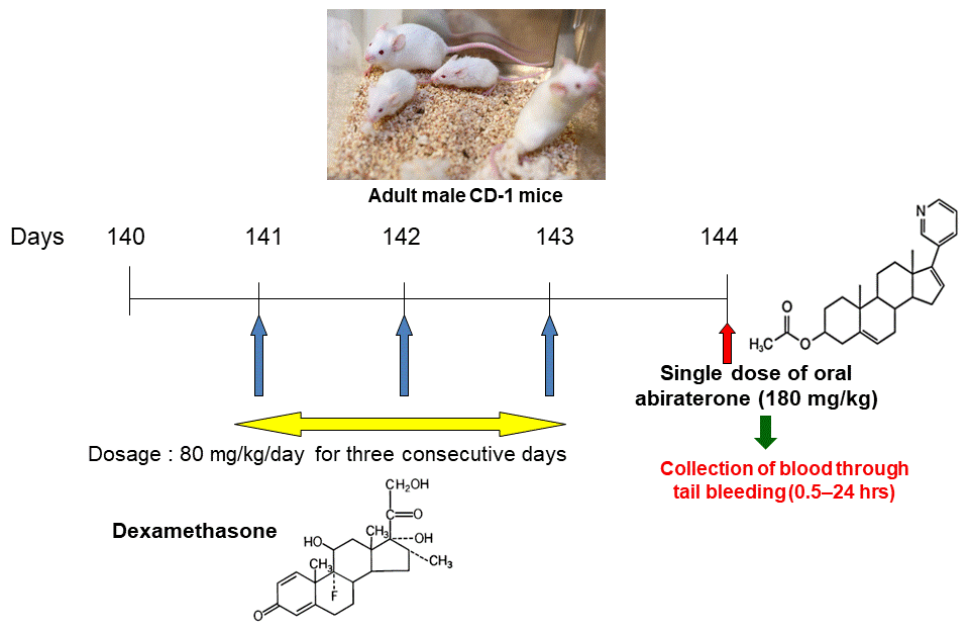
Figure 1. Study design involving treatment of adult male CD-1 mice with intraperitoneal dexamethasone followed by a single oral dose of abiraterone acetate.